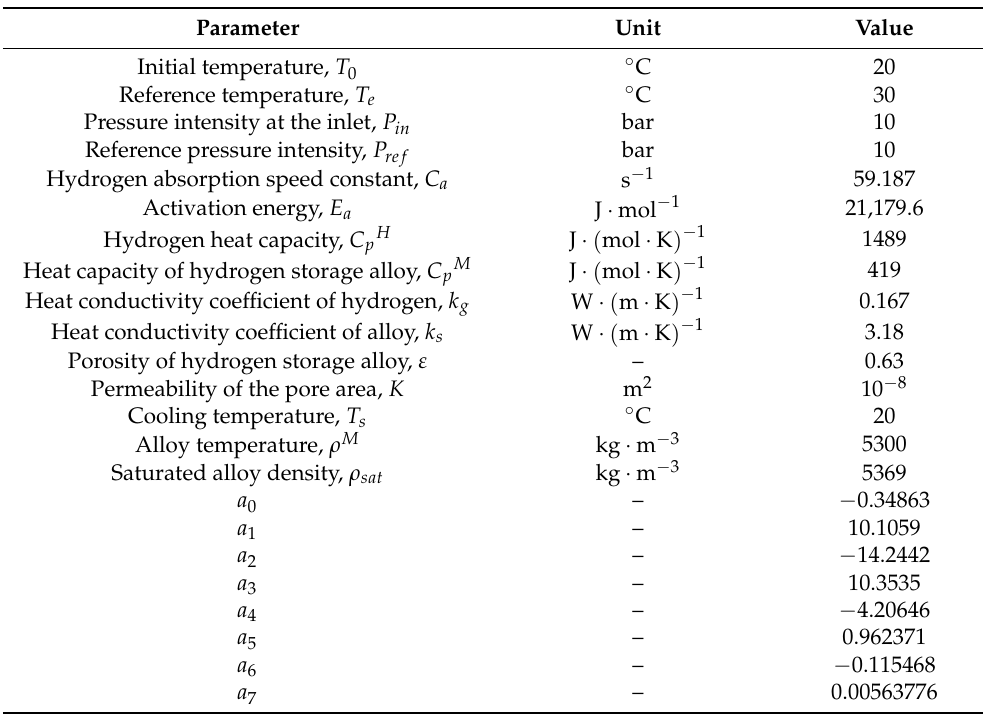
Table 1. This is a table. Tables should be placed in the main text near to the first time they are cited